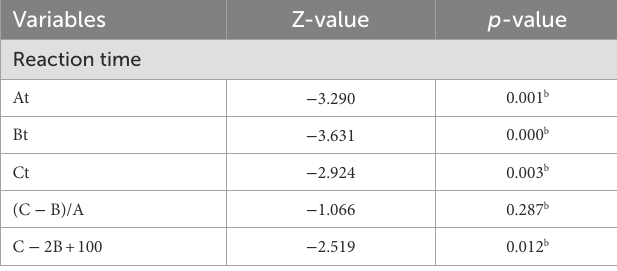
TABLE 4 Comparison of 41 patients and 42 healthy controls in SCWT.